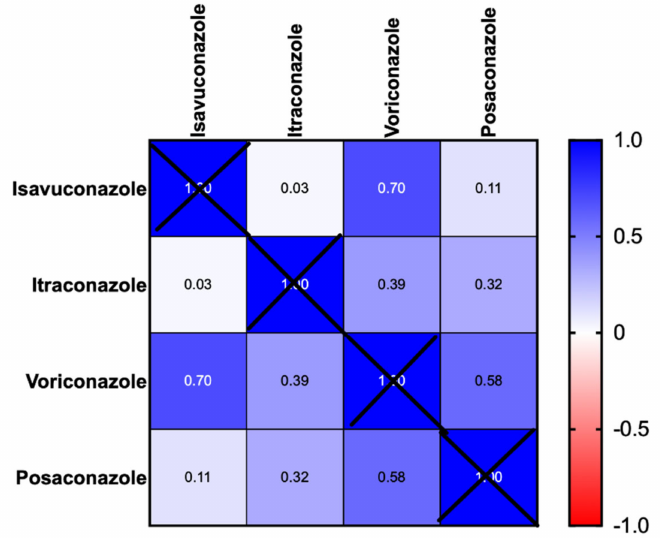
Figure 2. Correlation matrix of triazole MIC (Minimum Inhibitory Concentrations) for all clinical isolates throughout the study period.